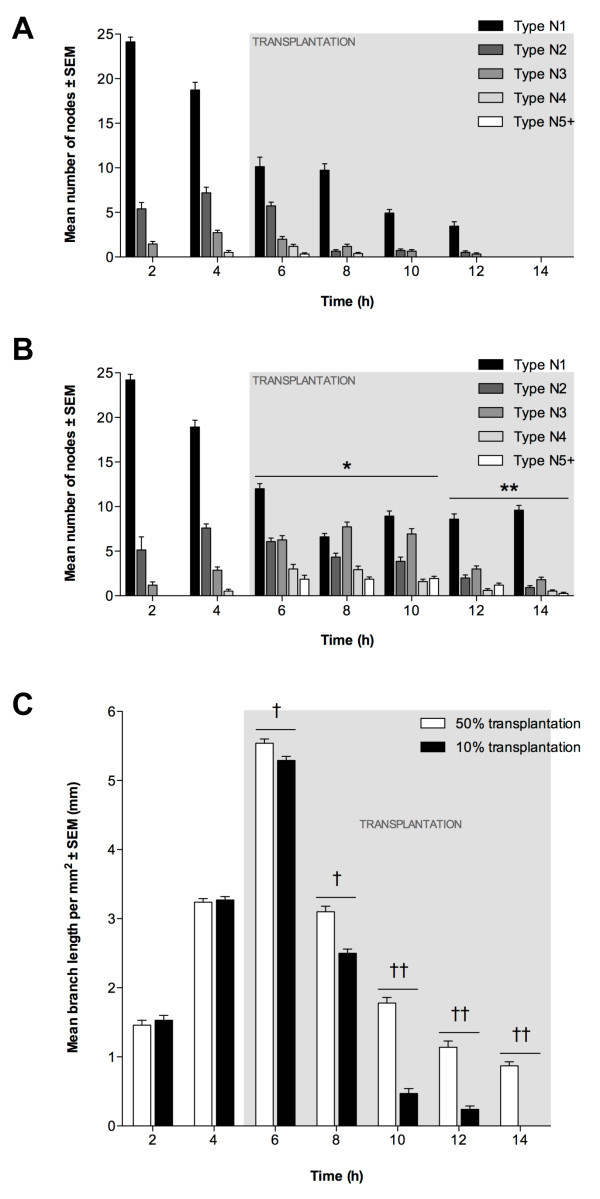
In vitro EPC transplantation into EC tubules. Transplantation using 10% (8 × 103) or 50% (4 × 104) EPCs at 5 h. Node counts of (A) 10% and (B) 50% transplantation (± SEM, n = 3). *P < 0.05 and **P < 0.01 vs. 10% EPC transplantation at same time-point. (C): Mean tubule length per mm2 (±SEM; n = 3). Significant differences between transplantations indicated (†P < 0.05, ††P < 0.01).